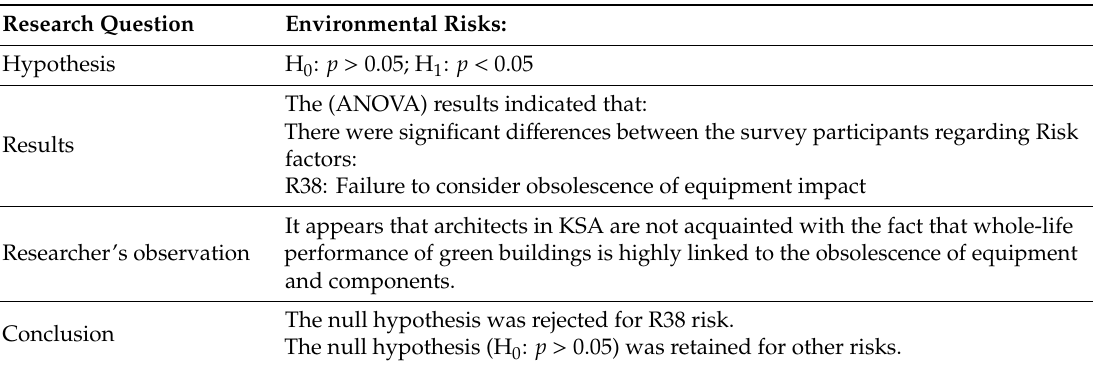
Figure 7. Ranking the environmental risk factors impacting on the project value. Table 6. Environmental risks and hypothesis test